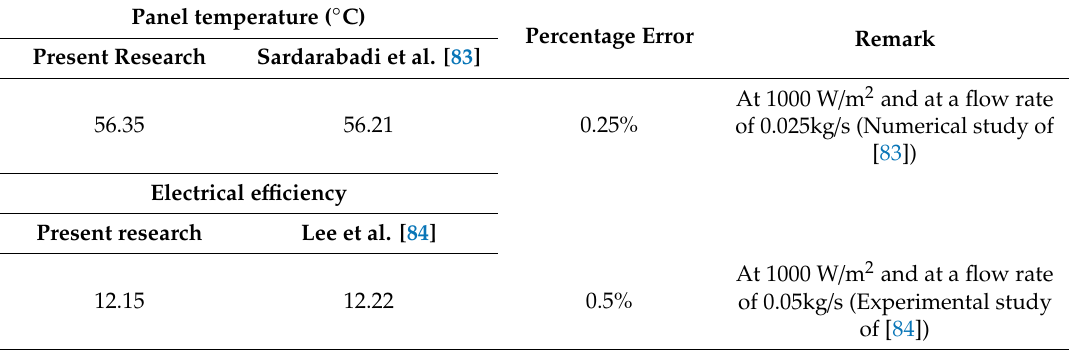
Table 7. Code validation of PV panel surface temperature and electrical e ffi